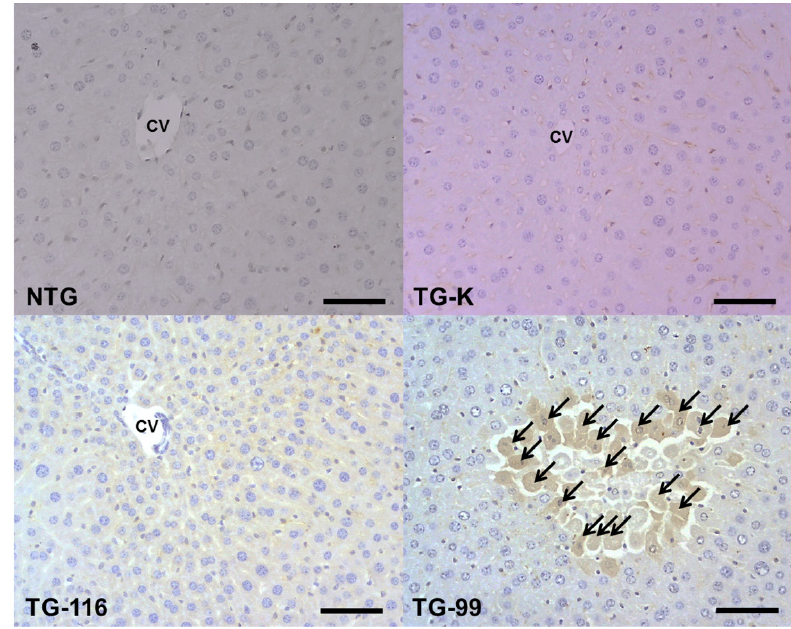
Figure 8. Immunohistochemistry staining of p21. In the TG99, there were lots of p21 positive hepatic cells near central veins. Arrows indicate p21 positive cells. Scale bar = 50 μ m. CV, central